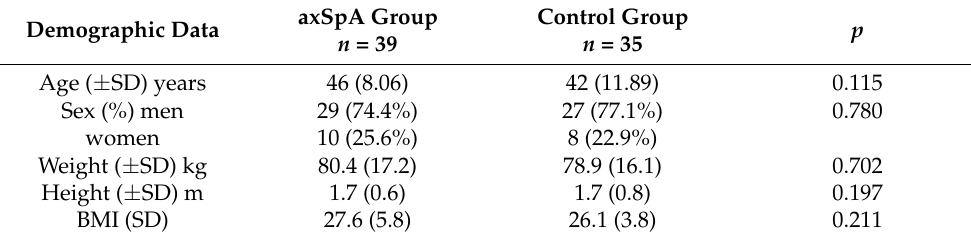
Table 1. Demographics data in both